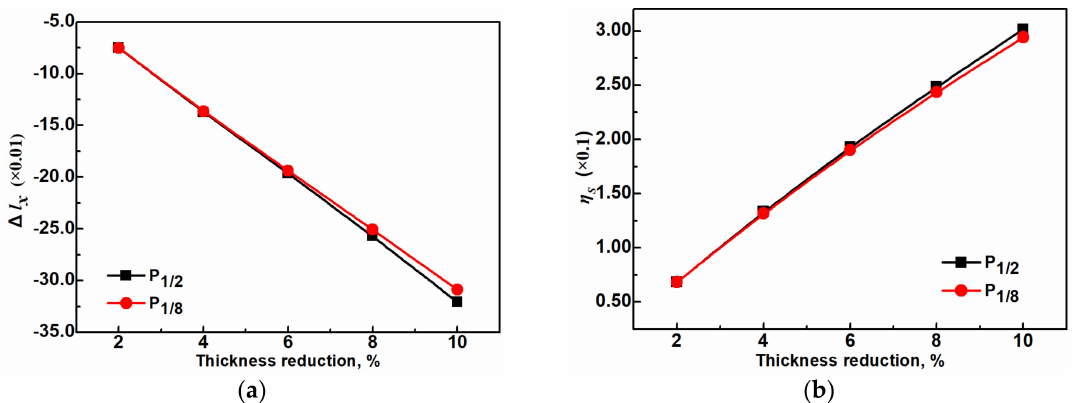
Figure 11. ( a ) Porosity deformation degree along the thickness direction and ( b ) porosity closure degree after different HR deformation implemented at the strand solidification end under condition of uniform